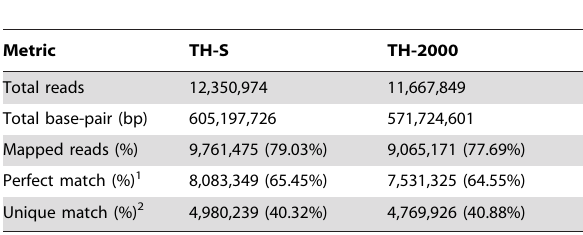
Table 1. Summary of RNA-seq metrics from B. tabaci